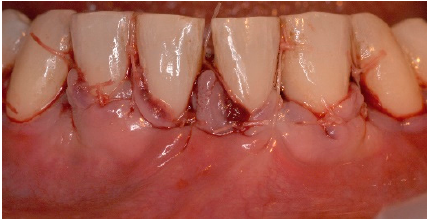
Figure 7. EMD was applied also on top of the soft tissue graft.